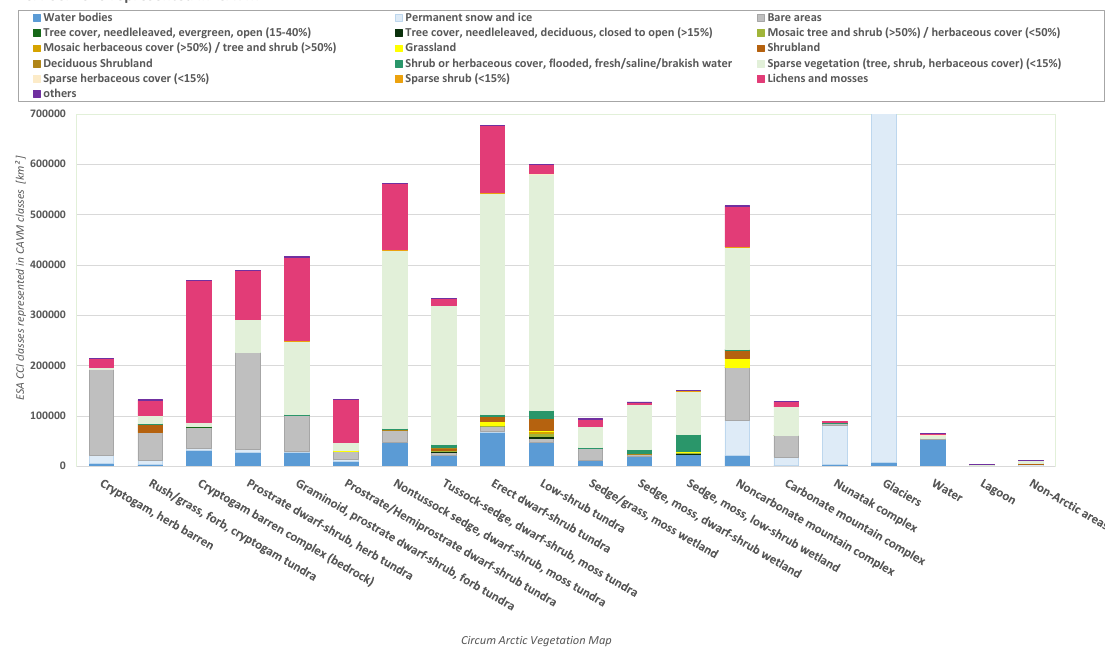
Figure 5. Comparison of CCI Land Cover 2010 classes with CAVM